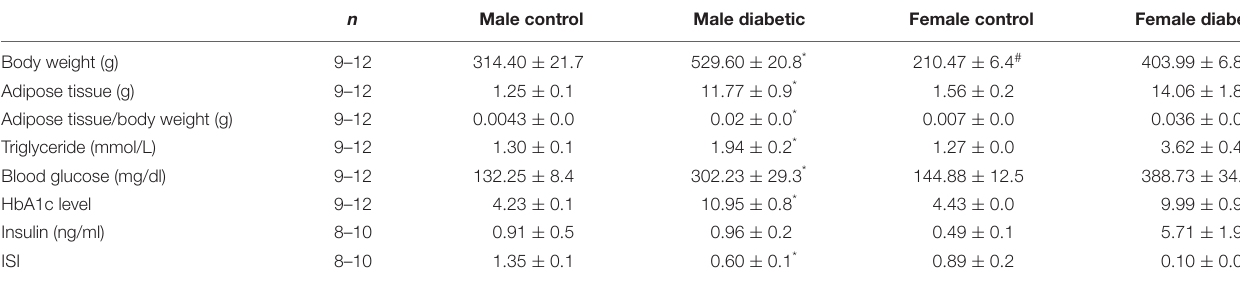
TABLE 1 | Body weight and adipose weight, blood glucose levels, HbA1c, and other metabolic parameters of male and female control and diabetic